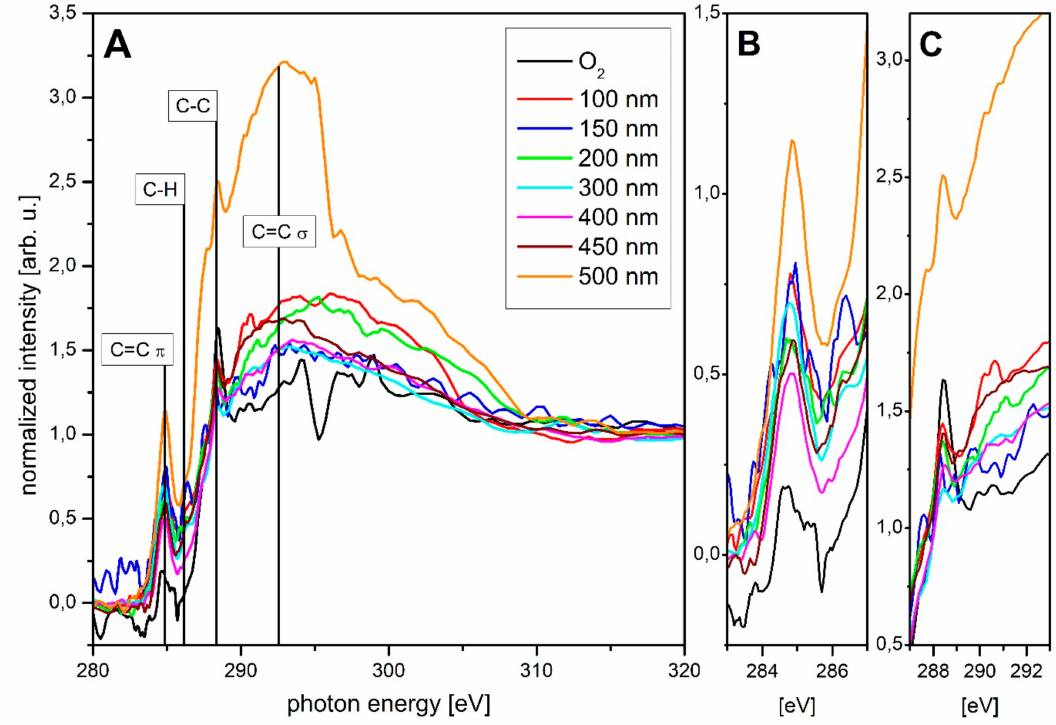
Figure 5. C K-edge near-edge X-ray absorption fine structure (NEXAFS) spectra of an O 2 treated PBAT sample as well as a-C:H coated PBAT with presented layer thicknesses of 100-500 nm in 100 nm steps. ( A ) displays full spectra, ( B , C ) zooms for 283 eV to 287 eV and 287 eV to 293